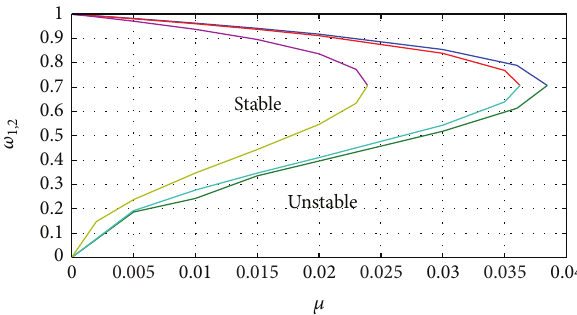
Figure 17: Combined graph for binary systems Achird-I, II, and III.